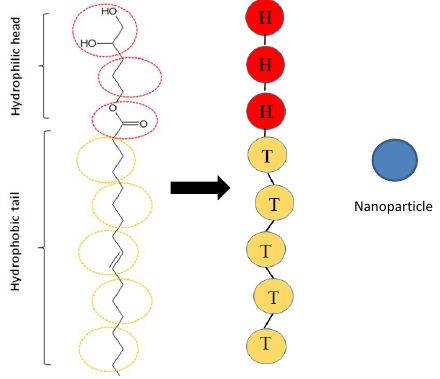
Figure 1. DPD model of the lipid molecule and the nanoparticle. The atomistic representation of a lipid molecular structure consisting of one head group and one tail group is demonstrated in the leftmost column, and the corresponding coarse-grained model is shown in the middle column. Hydrophilic head beads are indicated in red, and hydrophobic tail beads are represented in yellow. The rightmost side shows a schematic representation of the nanoparticle, which is indicated by blue